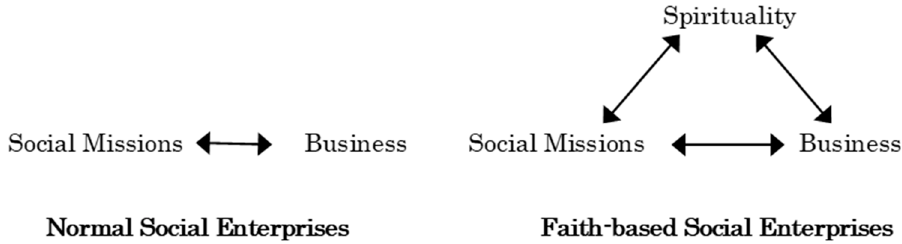
Figure 1. Tensions associated with hybrid forms of social enterprises. Source: Author.